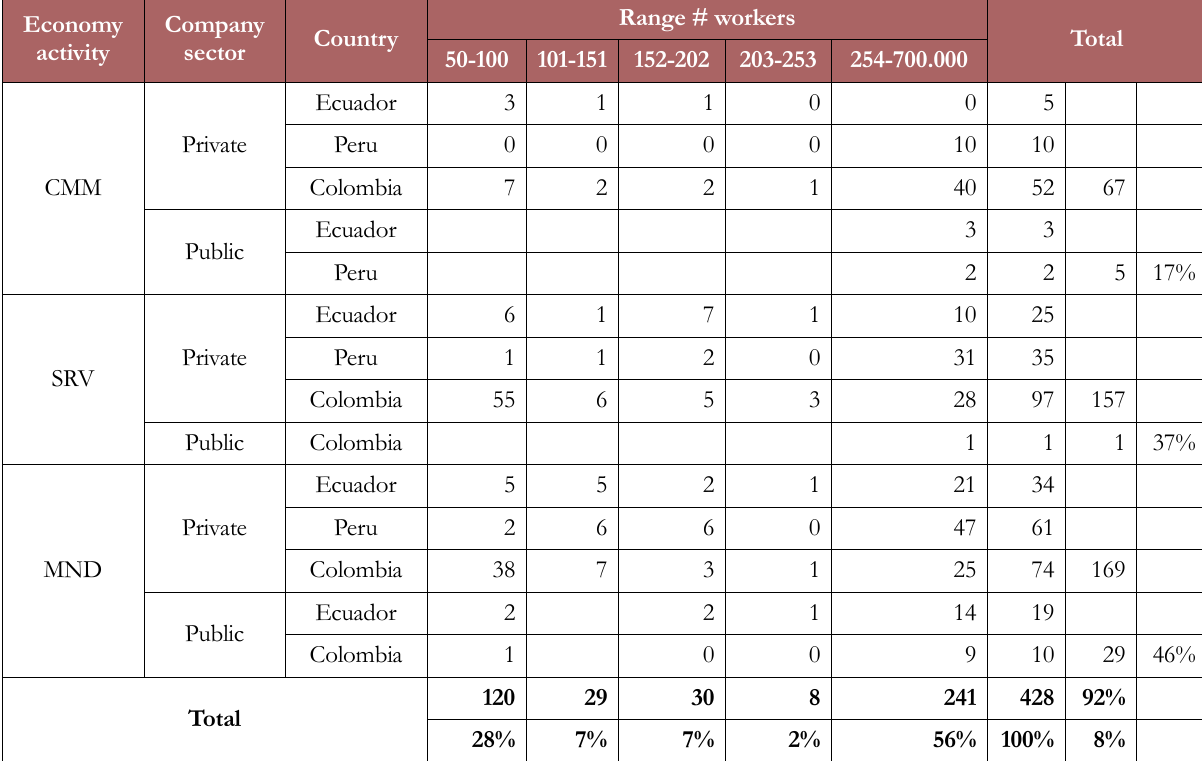
Table 2. Summary of descriptive statistics of the